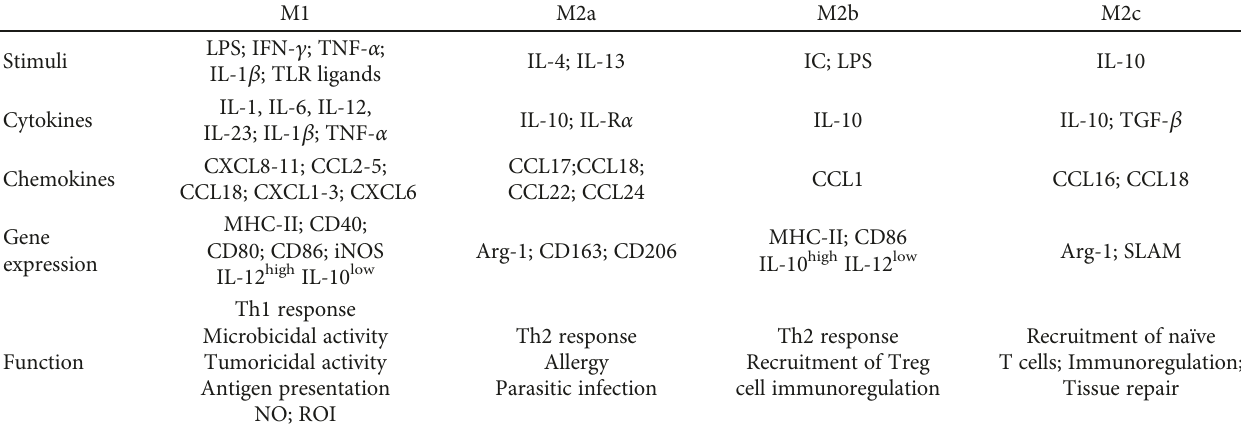
Table 1: Macrophages polarize into M1 (proin fl ammatory) and M2 (anti-in fl ammatory)